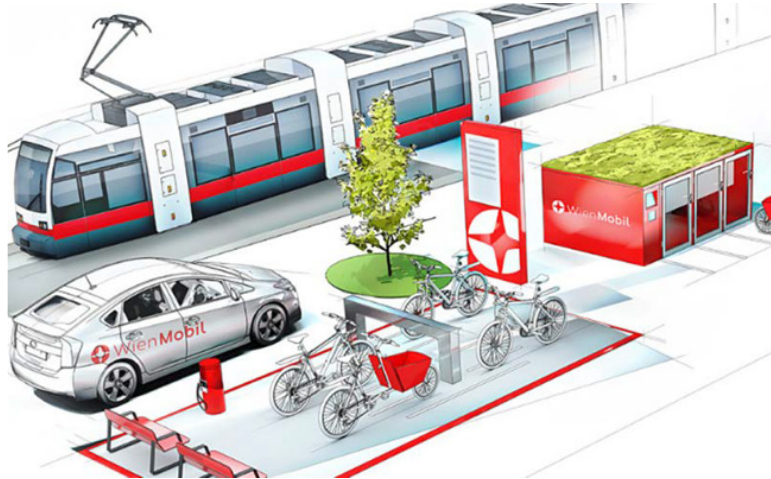
Figure 1. Mobility hub in Vienna. Source: City of Vienna